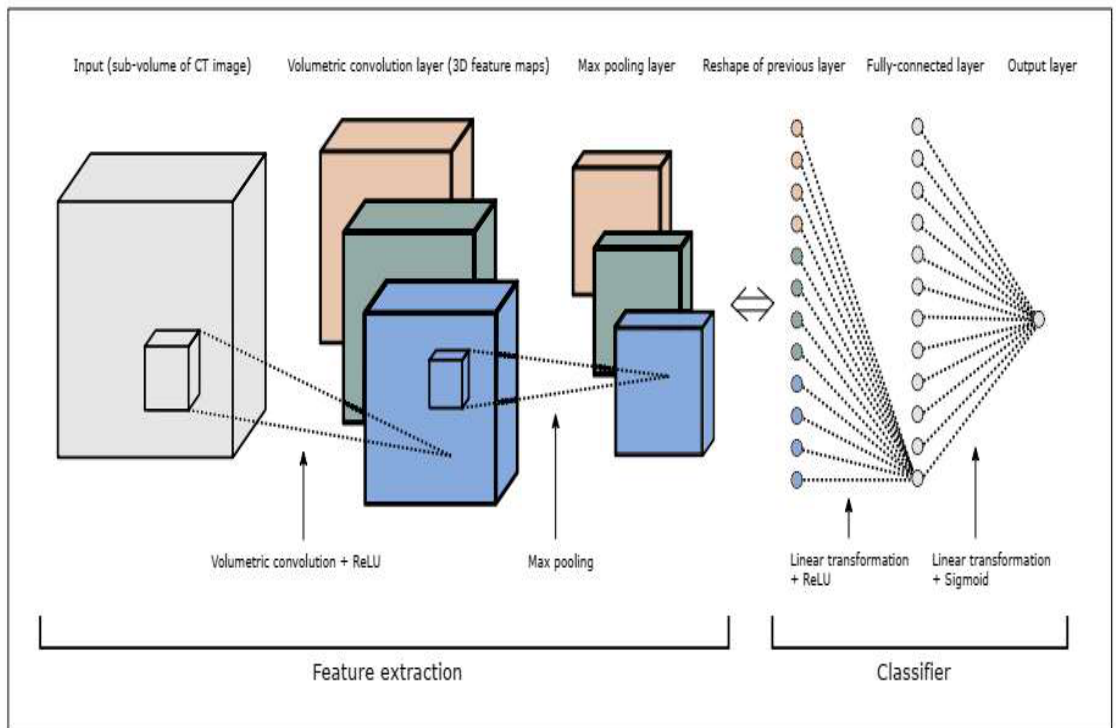
Figure 7. The architecture of a